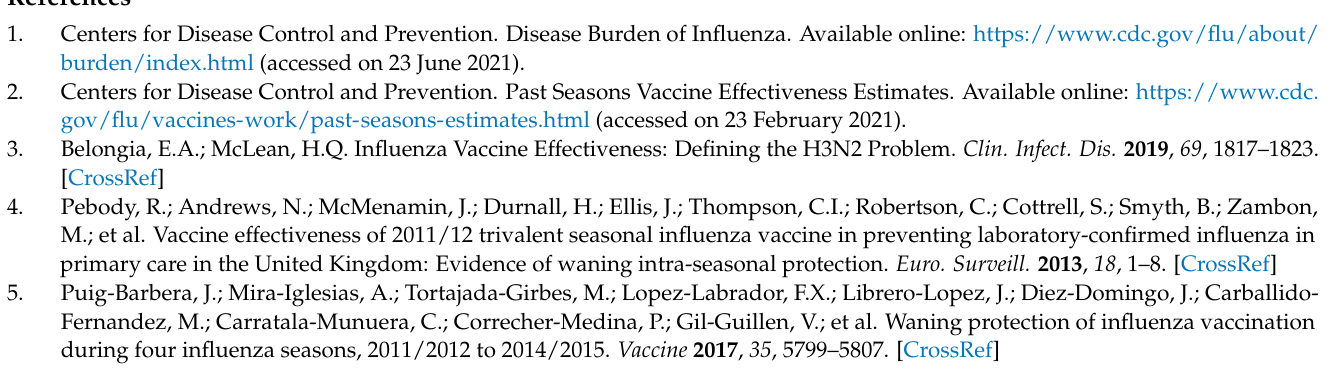
(Safety Set); Table S2: Most Frequent Treatment-Related Treatment-Emergent Adverse Events; Table S3: Seroconversion at Day 28 by Treatment Group and Baseline HAI Titer; Table S4: Seroprotection